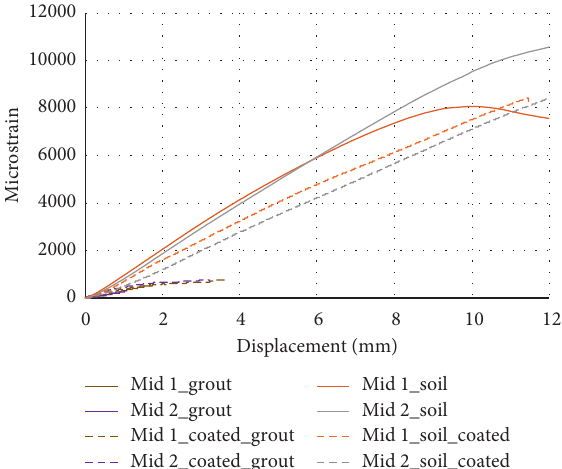
Figure 28: Strain vs. displacement at midpoints for coated and uncoated GFRP rock bolt